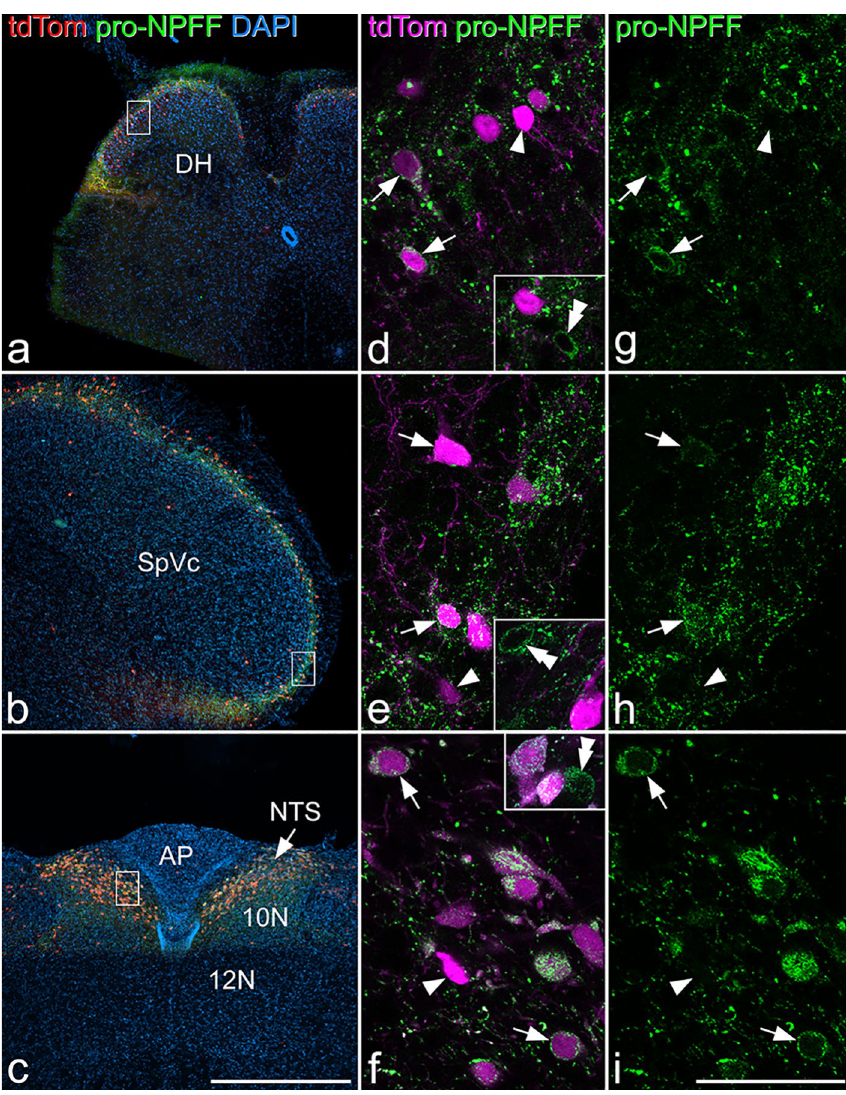
Figure 1. tdTomato-positive cells in the NPFF Cre ;Ai9 mouse. ( a ), ( b ) and ( c ) show low-magnification views through the spinal cord, spinal trigeminal nucleus and nucleus tractus solitarius (NTS), respectively. Cells labelled with tdTomato (tdTom; red) are present at a high density in the superficial parts of the spinal and trigeminal dorsal horns and in the NTS. ( d - i ) higher magnification images from regions shown in the boxes in ( a – c) . TdTomato is shown in magenta, and pro-NPFF immunostaining in green. Several td-Tomato-containing cells are pro-NPFF-immunoreactive, and some of these are marked with arrows. Arrowheads in these images indicate tdTomato-containing cells that do not contain detectable pro-NPFF. Insets in ( d – f) include cells that are pro-NPFF-immunoreactive, but do not contain tdTomato (double arrowheads). Quantitative analysis of the superficial dorsal horn of the spinal cord revealed that 38% of tdTomato-labelled cells were pro-NPFF- immunoreactive, while 83% of pro-NPFF-immunoreactive cells were tdTomato-positive. Images in ( a ), ( b ) and ( c ) are maximum intensity projections of 4, 7 and 14 optical sections, respectively, each at 4 μm z-separation. Main images and insets in ( d ), ( g ), ( e ) and ( h ) are projections of 2 images at 1 μm z-separation. Main images in ( f ) and ( i ) are single optical sections, while insets are projections of 3 optical sections at 1 μm z-separation. Scale bars: a - c = 500 μm, d - i = 50 μm. Abbreviations: AP, area postrema; DH, dorsal horn; NTS, nucleus tractus solitarius; SpVc, spinal trigeminal nucleus caudal part; 10N, motor nucleus of vagus; 12N, hypoglossal